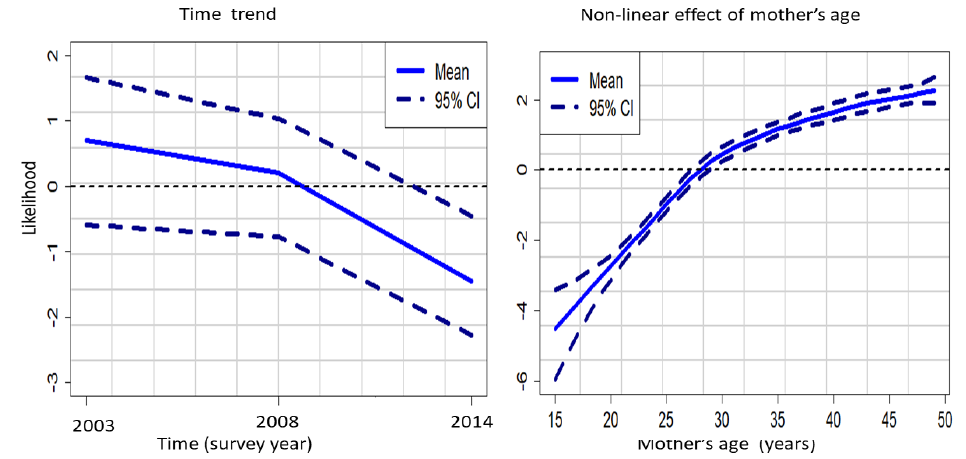
Figure 8. Time trend (left panel) and non-linear effect of mother’s age (right panel). Evidence from the KDHS 2003 to 2014 pooled data Model C*.